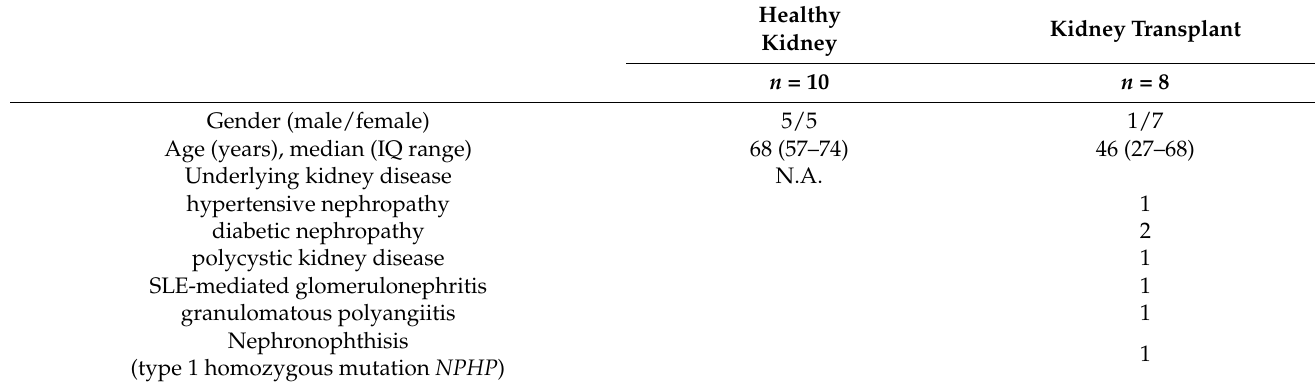
Table 1. Clinical characteristics study